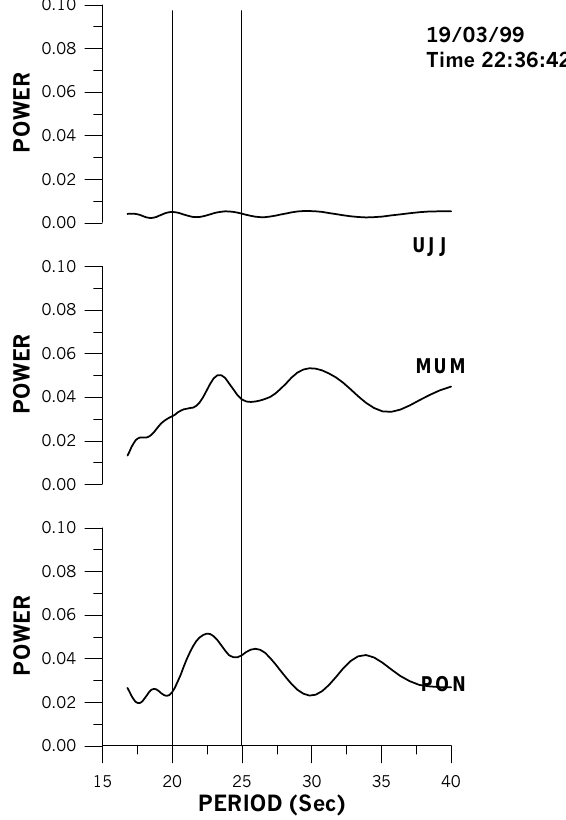
Fig. 7. Power spectrum of the 2 s averaged filtered scintillation on the specified day, at local time and at the specified stations. The plot shows spectral peaks around the eigen-period at Pondicherry and Mumbai, but does not show any such peak at Ujjain. The range of the eigen-period has been marked by the interval between two vertical lines.